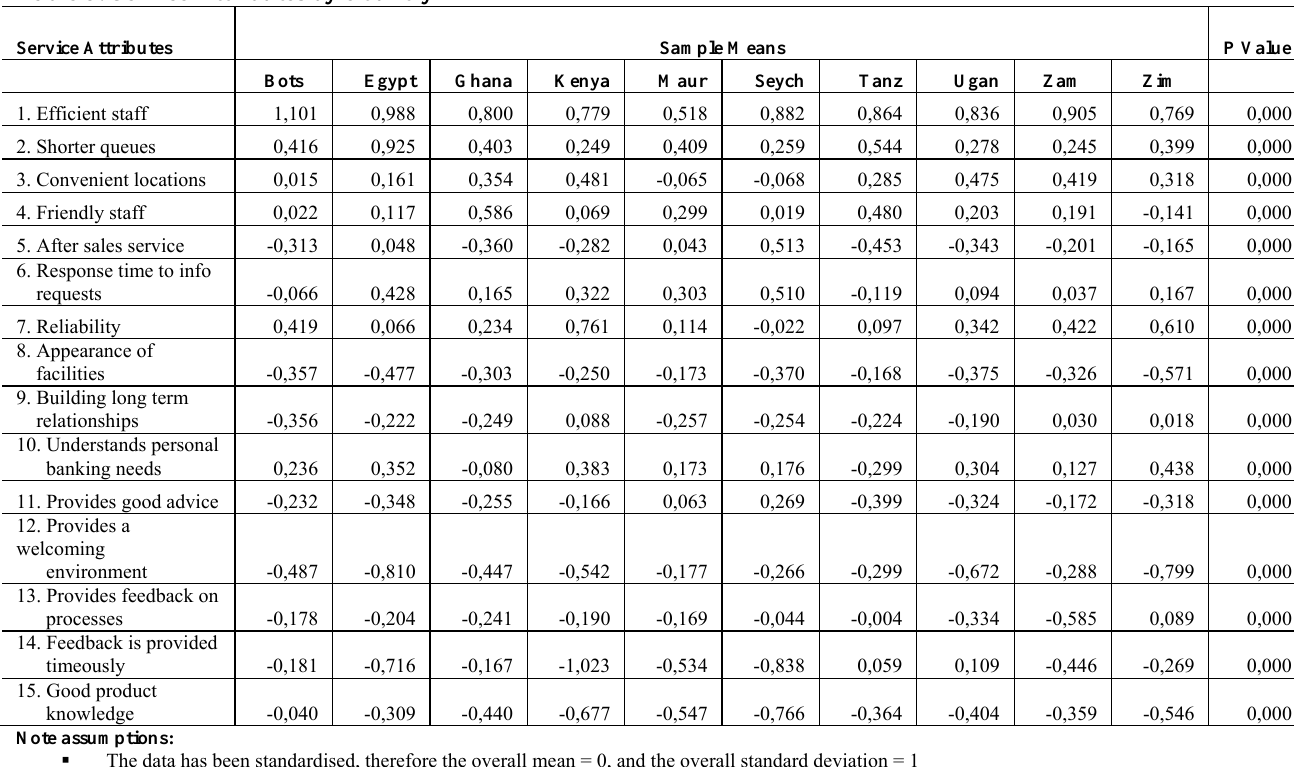
Table 5: Service Attributes by